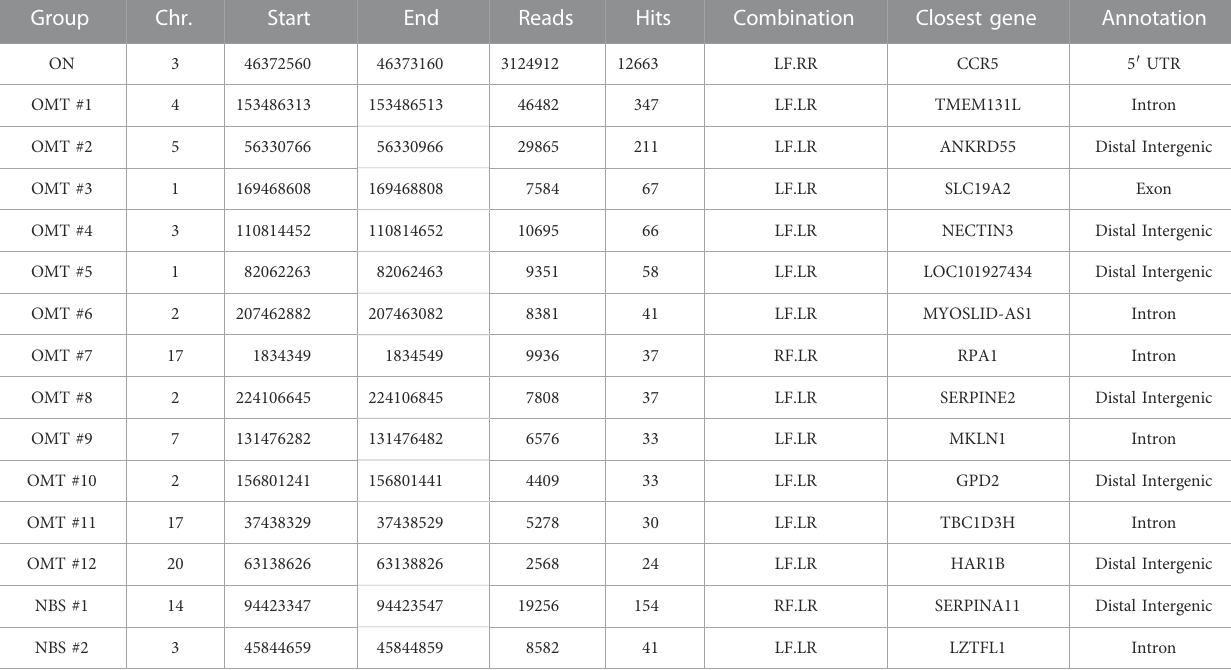
TABLE 2 T-CAST results for CCR5 -targeting TALEN. Listed are OMTs with > 20 hits and NBSs with > 40 hits. TALEN combinations: LF, left TALEN arm in forward orientation; LR, left TALEN arm in reverse orientation; RF, right TALEN arm in forward orientation; RR, right TALEN in reverse orientation. Group Chr. Start Reads Hits Combination Closest gene Annotation